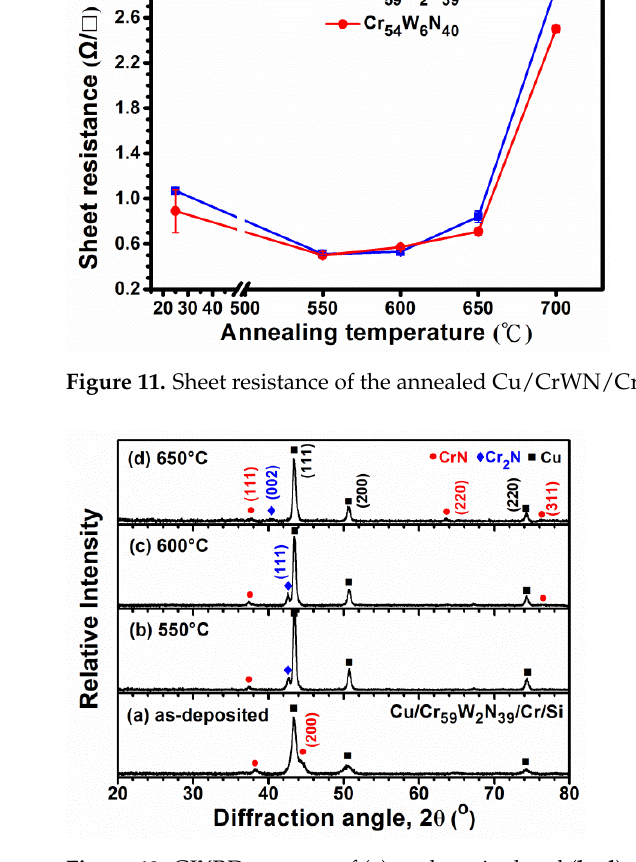
Figure 12. GIXRD patterns of ( a ) as-deposited and ( b – d ) annealed Cu/Cr 59 W 2 N 39 /Cr/Si samples.